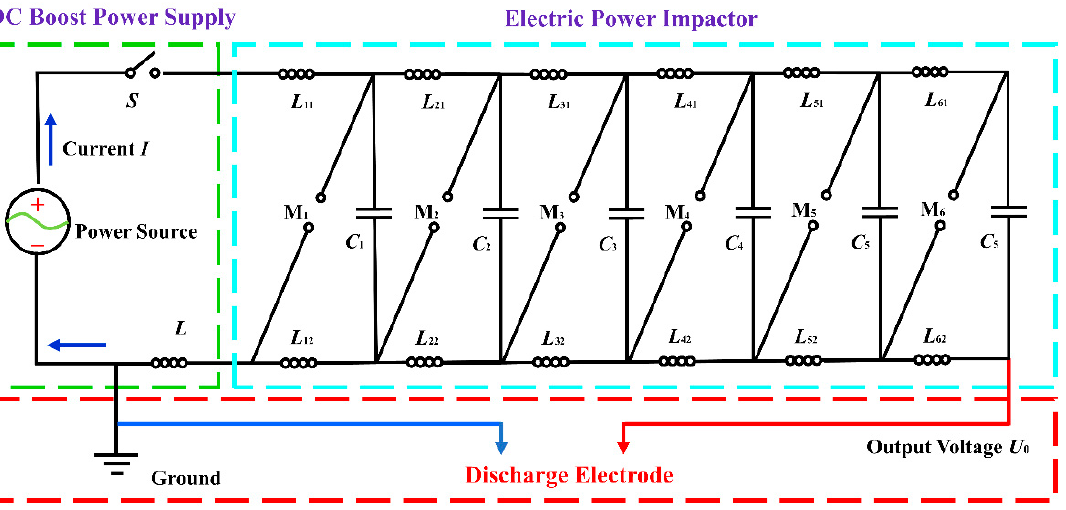
Figure 2. ( a ) Granite broken forms and ( b ) broken process under electropulse.